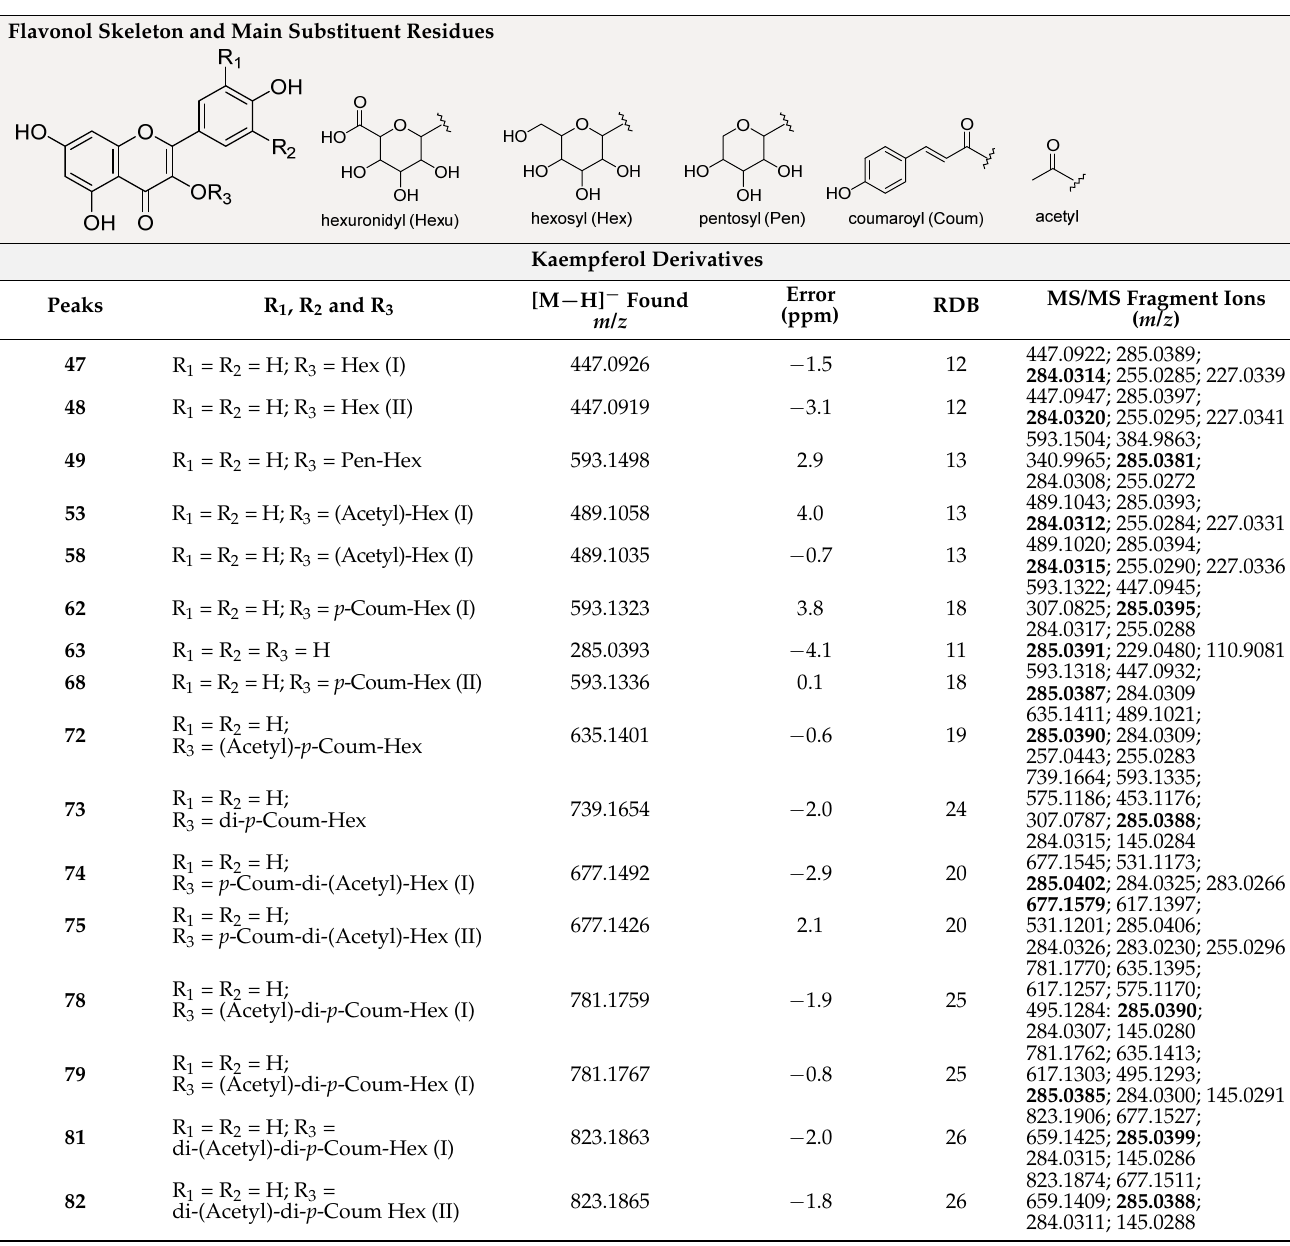
Table 2. Mono-, di- and acyl-glycosylated flavonols tentatively identified in oak leaf. RDB = ring double bond equivalent value. Base peak fragments are reported in bold.